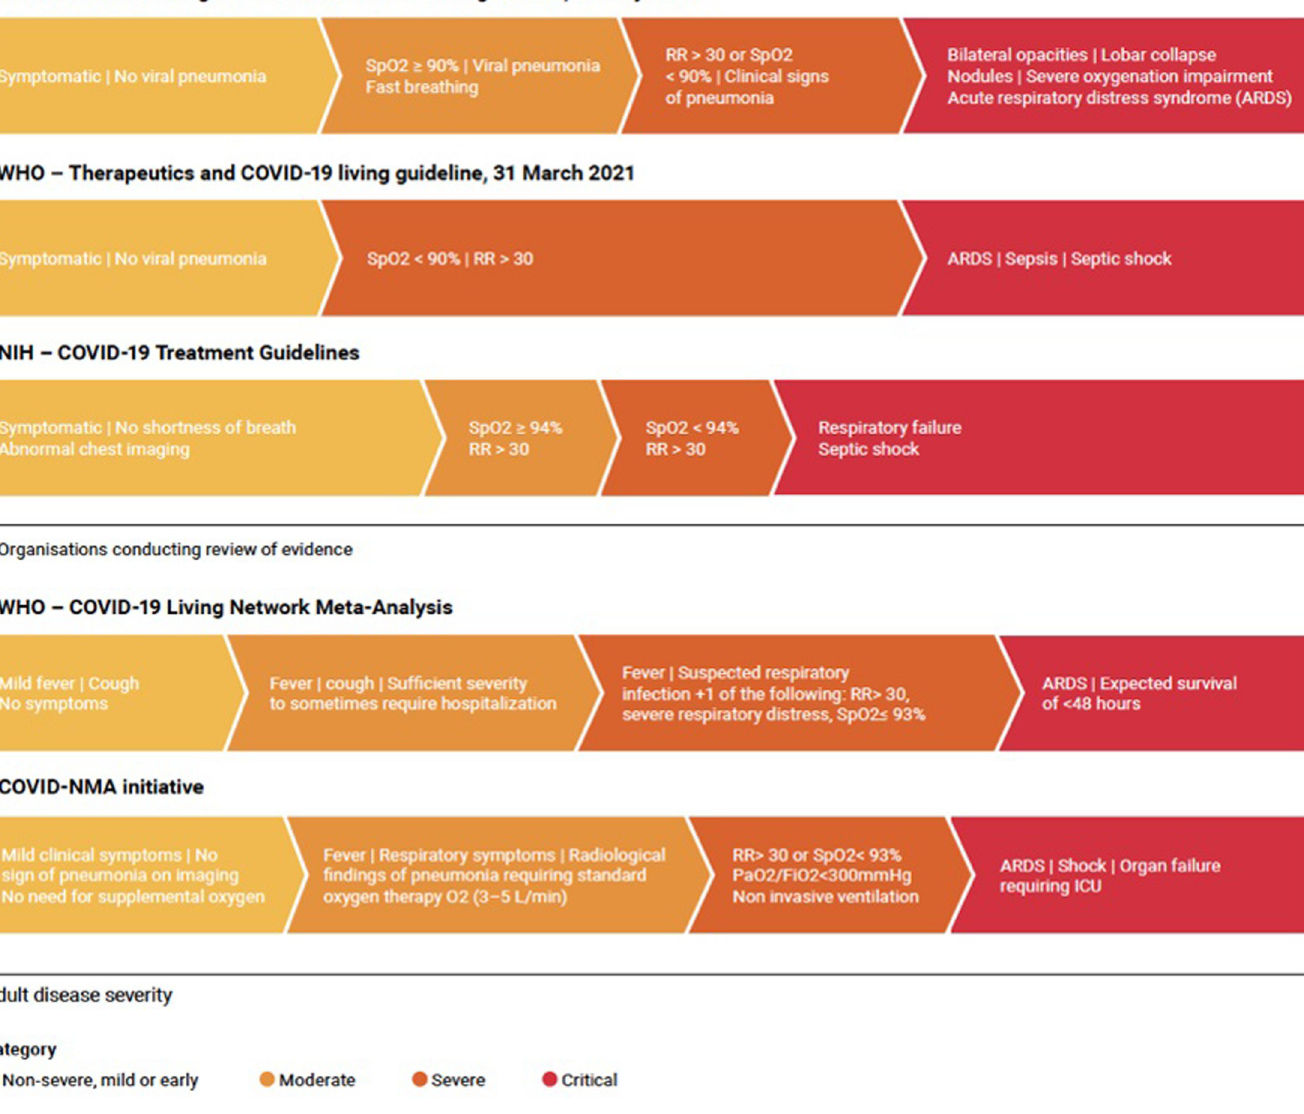
Fig 1. Severity definitions from WHO, US NIH guidelines and organisations conducting review of evidence i.e. the WHO—COVID-19 Living Network Meta- Analysis and the COVID-NMA imitative (RR: Respiratory rate; SpO2: Blood Oxygen Saturation; PaO2/FiO2: Ratio of arterial oxygen partial pressure (PaO2 in mmHg) to fractional inspired oxygen (FiO2 expressed as a